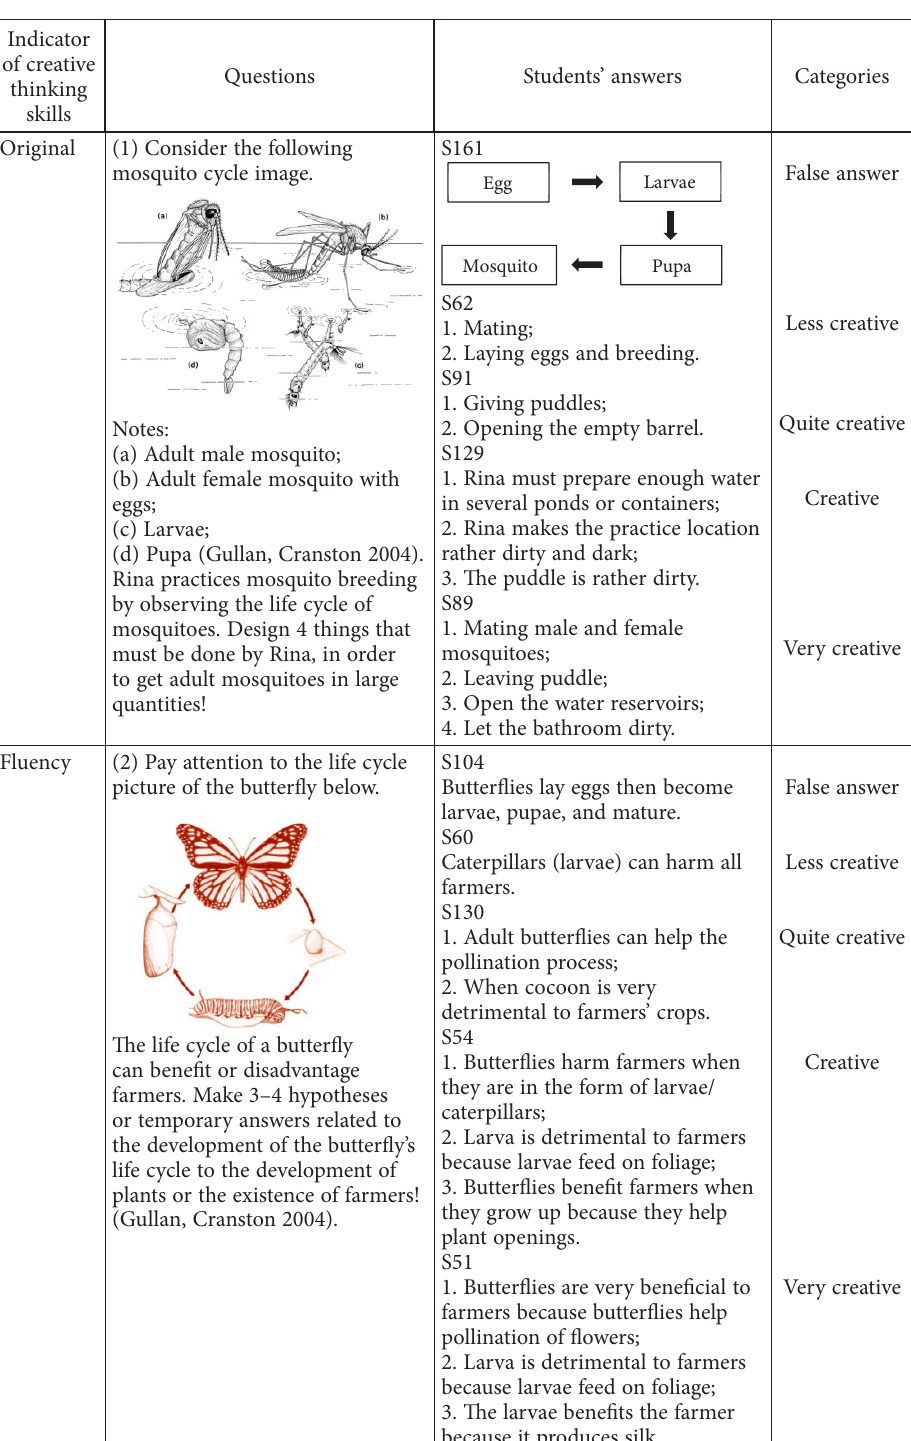
Table 1. Results of conversations with students for creative thinking skills (source: created by authors) Indicator of